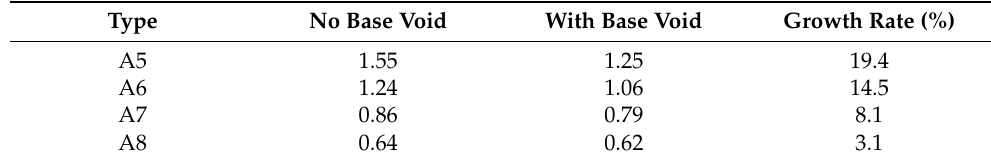
Figure 18. Acceleration time curve of soil measuring points below tunnel invert: ( a ) no base void; ( b ) with base void. Table 6. Peak acceleration of soil layer measuring points (m/s 2 ) .